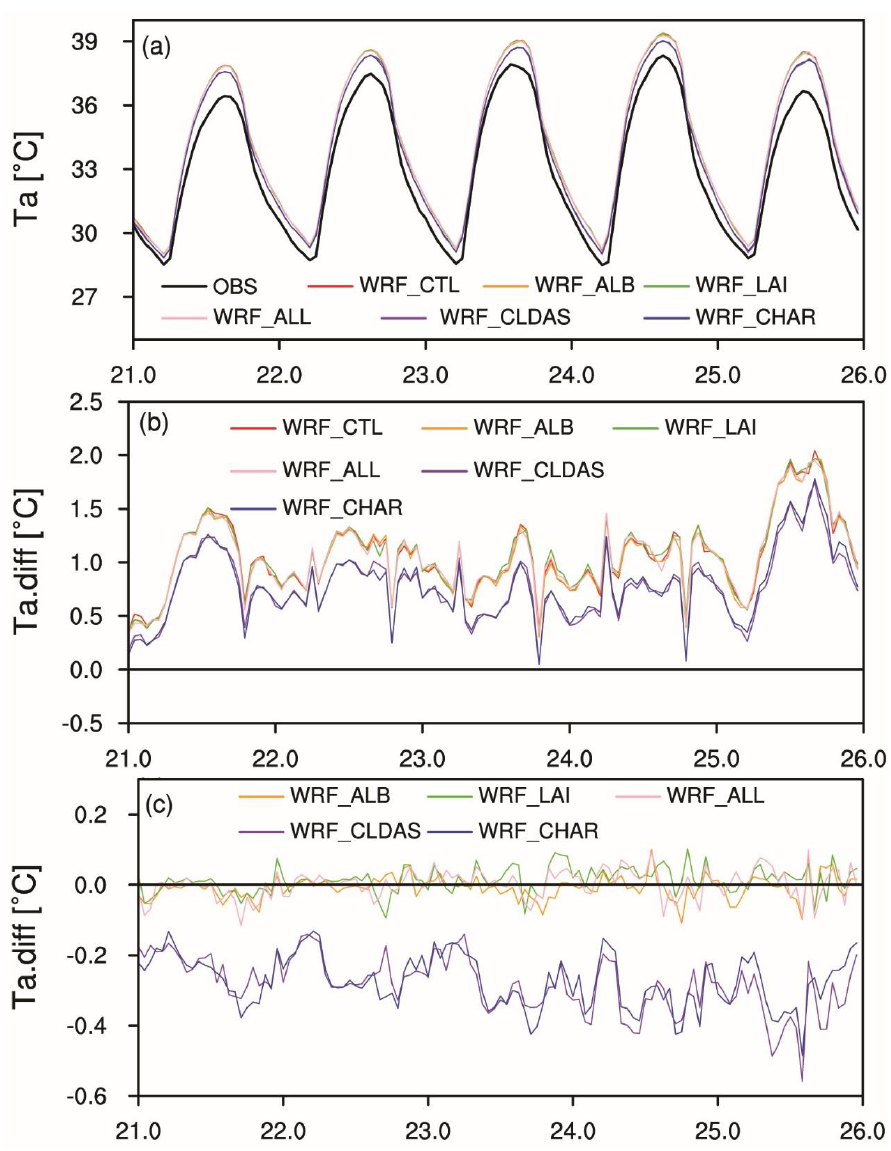
Figure 13. ( a ) Hourly variations of area-averaged observed and simulated air temperature and ( b , c ) their difference (unit: °C) over the research period by the supplementary simulation in EC.